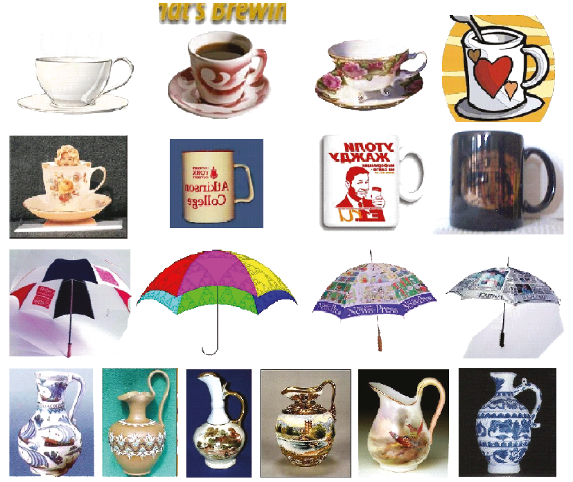
Figure 1: Examples of textured objects such as cups, umbrellas, and ewers (note the di ff erent surface